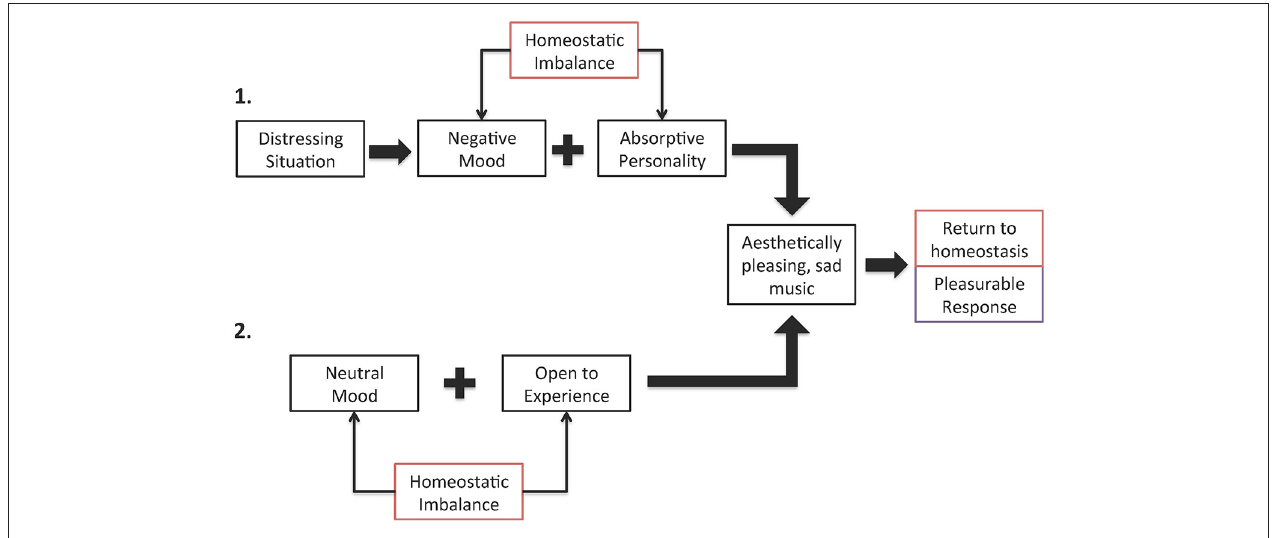
and thus resturning them to homeostasis. In example 2, for individuals who are highly open to experience, their state of optimal functioning occurs when engaged with diverse and arousing stimuli. Listening to sad music could induce a variety of emotions, serving as the desired diverse stimuli, which someone open to experience would find pleasurable because it returns them to this optimal